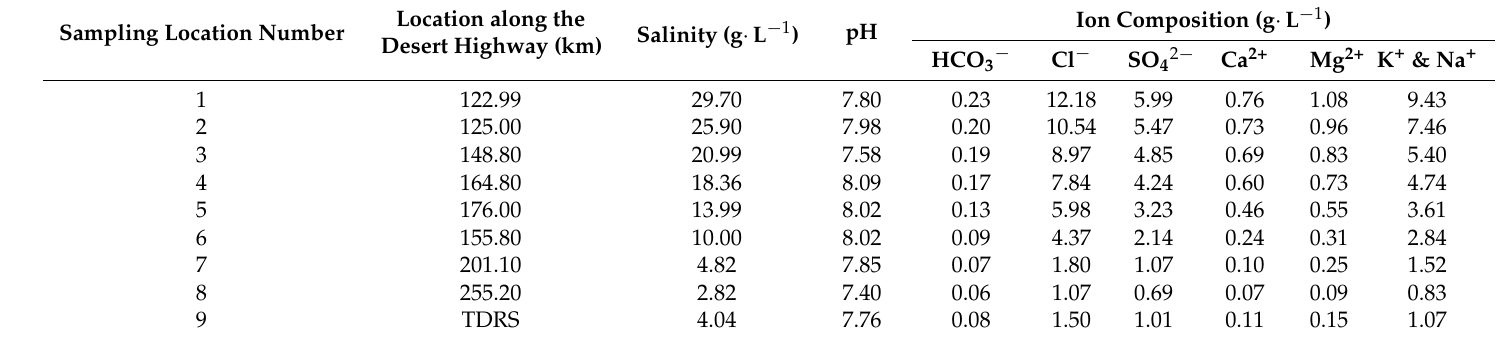
Table 2. Chemical properties of the irrigation groundwater in the study